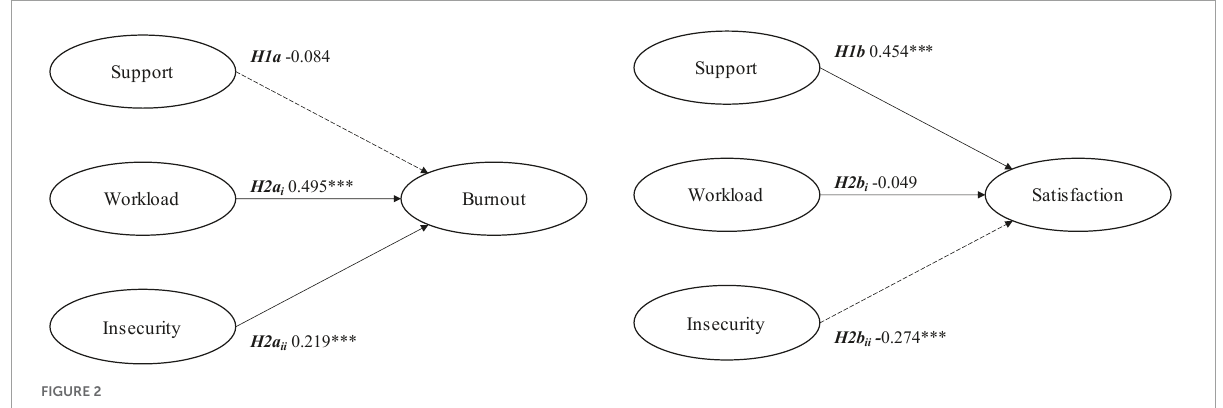
FIGURE2 Job demand-resource model in family business. Hypotheses testing.